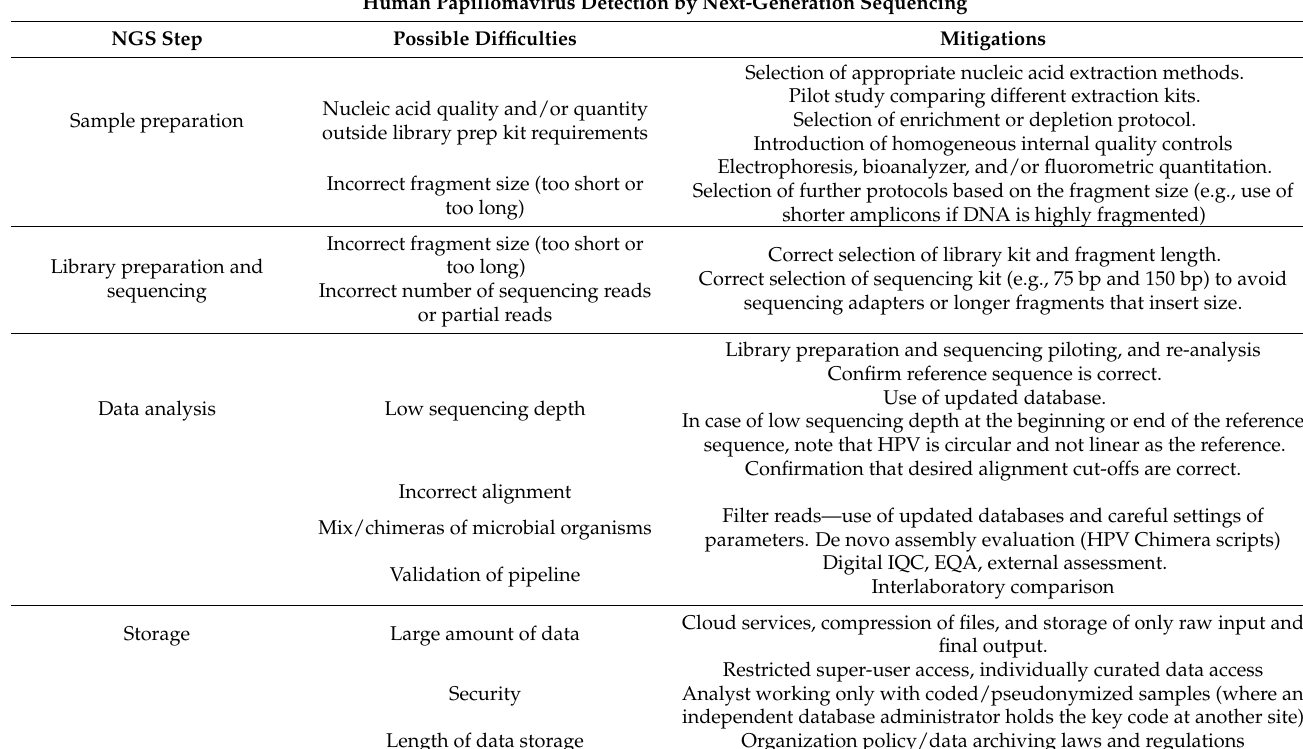
Table 1. Steps, potential quality issues, and proposed mitigations for next-generation sequencing (NGS) analytical workflow, with a focus on whole-genome sequencing